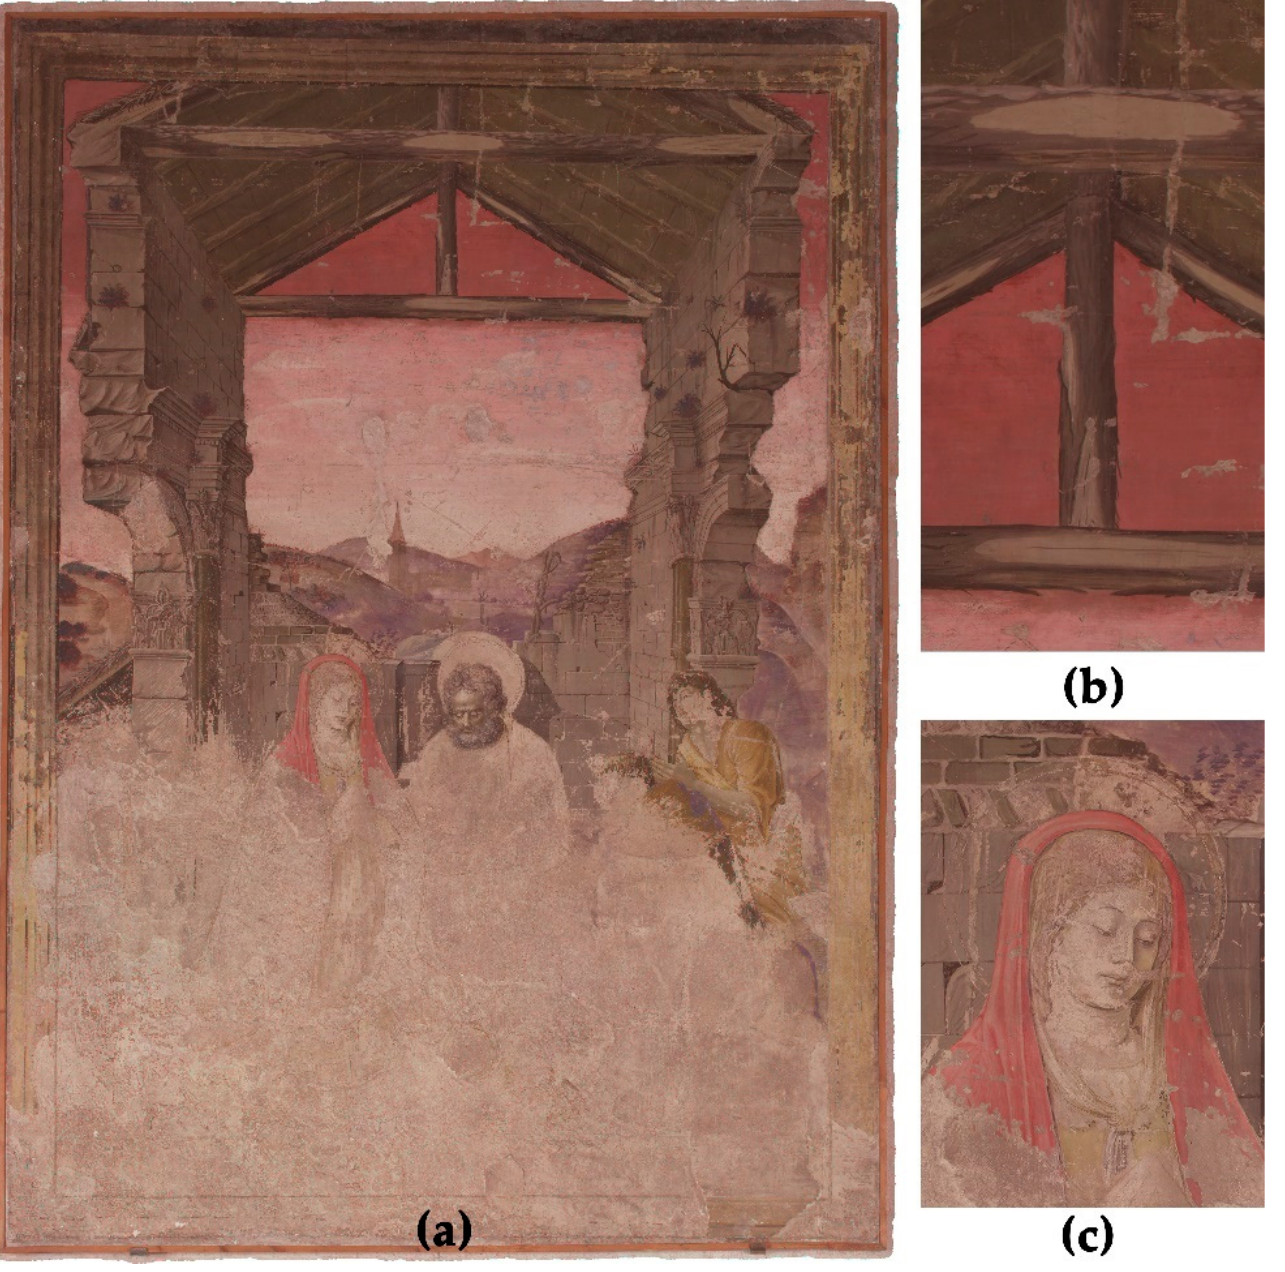
Figure 6. ( a ) False colour infrared image ( FCIR) based on the monochrome spectral bands of IR- R _IR_850 and the red and green bands of the VIS-R _VIS . This hybrid image helps to compare the blue pigments used in the mural painting. The blue pigments used for the sky ( b ) and for Marias vail ( c ) behave identically in FCIR.